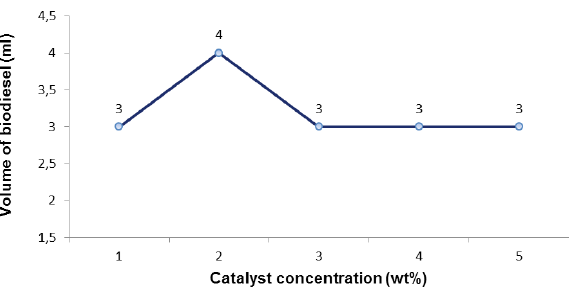
Figure 5 : The effect of different temperatures on the transesterification of used cooking oil. Conditions: reaction time of 2 hours, methanol to oil ratio 4:1, catalyst weight